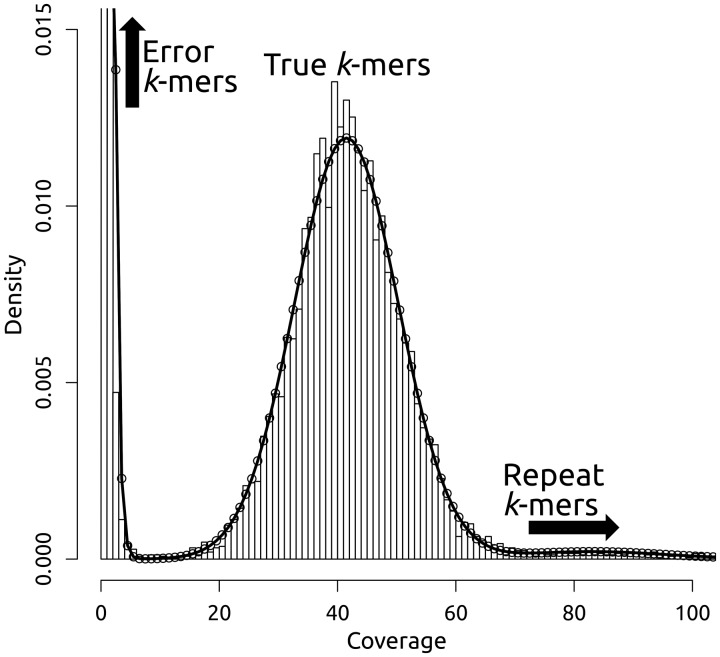
k-mer coverage histogram with a model fit. The histogram in this plot from the Quake paper [70] gives a nice example of an empirical k-mer coverage distribution. The density tells us which proportion of all existing k-mers in the data set has a particular coverage. The solid line gives the Quake model fit. The first peak of the distribution is formed by very low coverage error k-mers and is usually modelled by a Poisson or a Gamma distribution. The second peak results from the majority of correct k-mers and is usually modelled by a Poisson or a Gaussian distribution. Between these two peaks, a clear local minimum can provide a k-mer trust coverage cut-off. The heavy tail of higher multiplicity k-mers is the result of k-mers from sequence repeats. Quake draws the k-mers' sequence copy numbers from a Zeta distribution and then projects these k-mers into the coverage range of the correct k-mers. Adapted by font change and label addition from [70], according to the Creative Commons Attribution license CC-BY 2.0 (http://creativecommons.org/licenses/by/2.0/).